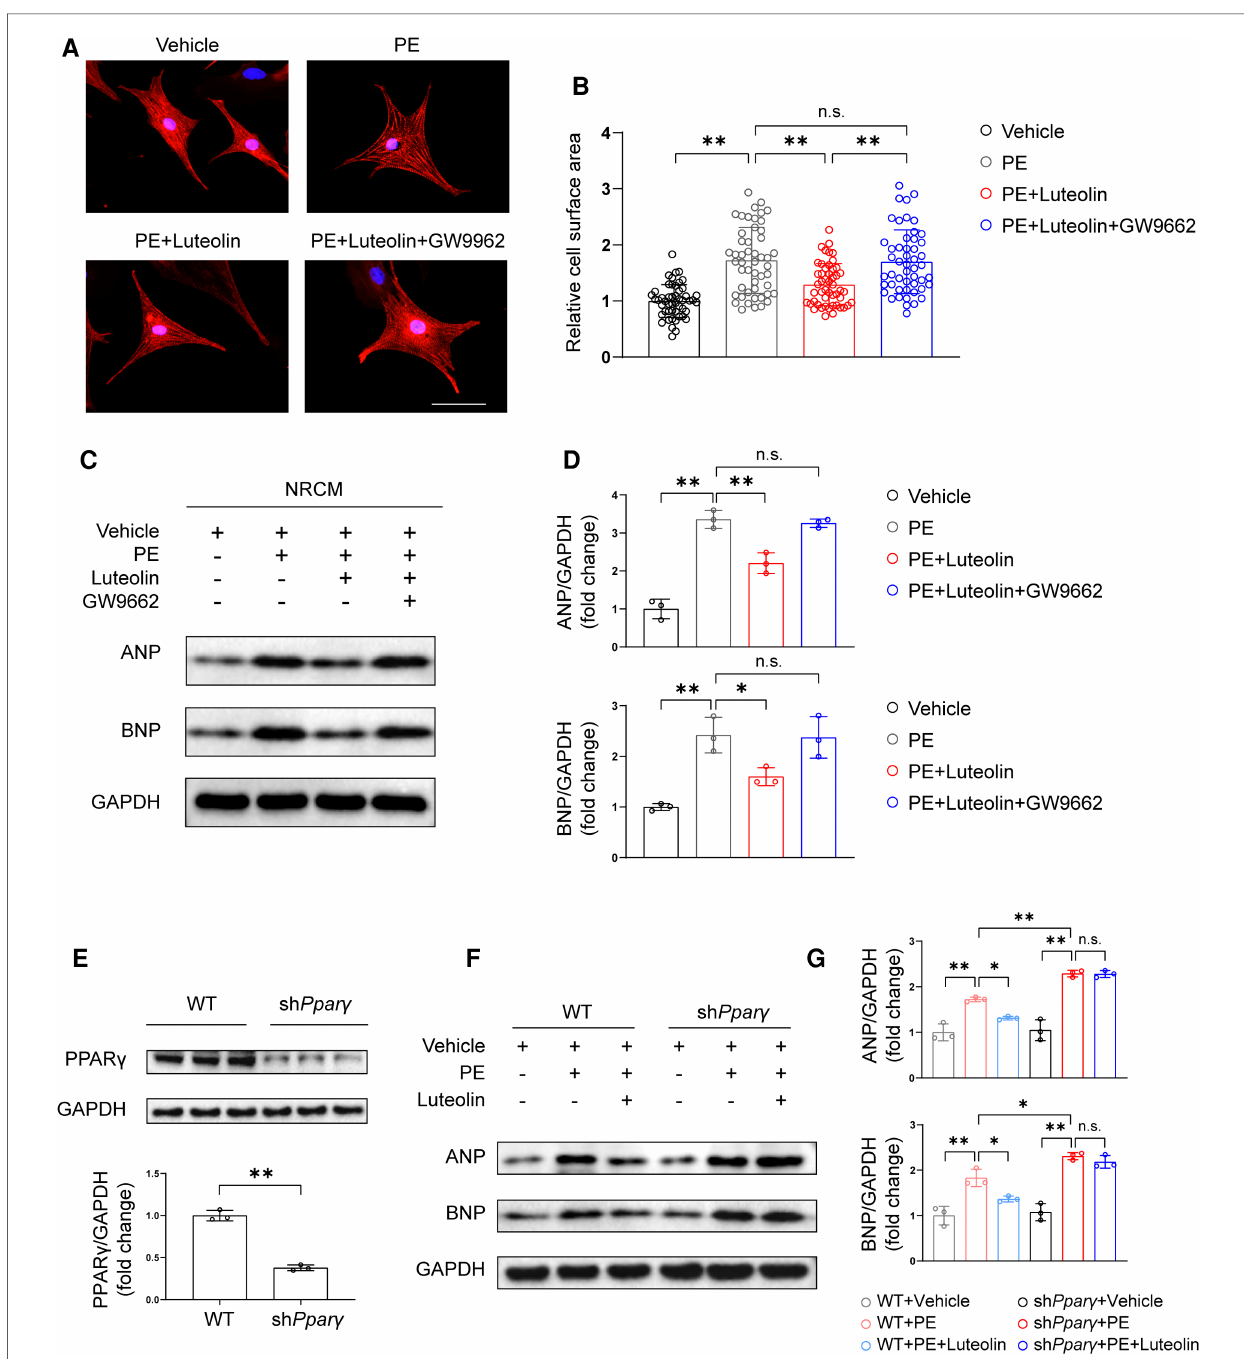
FIGURE 7 Luteolin inhibits cardiac hypertrophy in a PPAR γ -dependent manner. ( A ) Representative immuno fl uorescence images of α -actinin staining of NRCMs treated with PBS, PE (50 μ M), PE+luteolin (10 μ M), or PE+luteolin+GW9662 (20 μ M) for 24 h ( n ≥ 50 cells per group). Scale bar, 50 μ m. ( B ) Quantitative results of the cell surface area of NRCMs from the indicated groups. The data shown are representative of three independent experiments. ( C,D ) Immunoblotting analysis ( C ) and quantitative results ( D ) of ANP and BNP in cultured NRCMs treated with vehicle (PBS), PE (50 μ M), PE+luteolin (10 μ M), or PE+luteolin+GW9662 (20 μ M) for 24 h. The data shown are representative of three independent experiments. ( E ) Immunoblotting analysis (top) and quantitative results (bottom) of PPAR γ in cultured WT and PPAR γ knockdown H9C2. ( F,G ) Immunoblotting analysis ( F ) and quantitative results ( G ) of ANP and BNP in cultured cultured WT and PPAR γ knockdown H9C2 treated with vehicle (PBS), PE (50 μ M), and PE+ luteolin (10 μ M) for 24 h. The data shown are representative of three independent experiments. Values are presented as mean±SD. * P <0.05, ** P < 0.01, n.s., no signi fi cant difference. PPAR γ , peroxisome proliferator activated receptor γ ; NRCM, primary neonatal rat cardiomyocyte; ANP , atrial natriuretic peptide; BNP, b-type natriuretic peptide; PE, phenylephrine; WT,